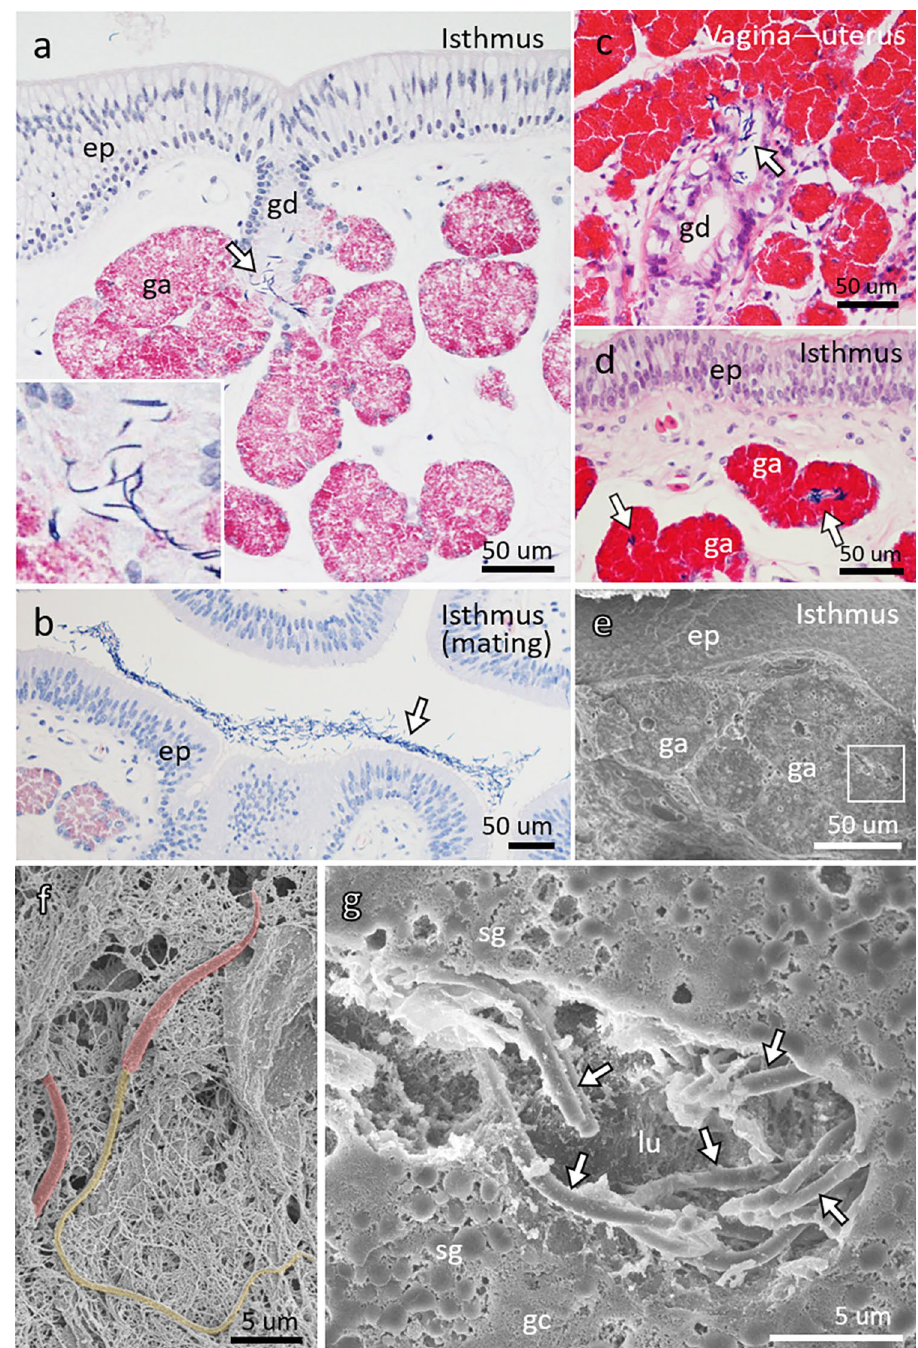
Figure 4. Sperm storage portion in oviduct of green turtle. ( a ) Sperm (arrow) in gland duct (gd) of isthmus in ID-024. Insert is higher magnification of sperm. ep, epithelium; ga, gland acini. ( b ) Sperm (arrow) in lumen of isthmus in ID-028 captured during mating. Spermatozoa are sparse in other parts of oviduct in this individual. ( c ) A few sperm (arrow) in gland ducts (gd) of transition area between uterus and vagina in ID-035. ( d ) Sperm (arrows) in gland acini (ga) of isthmus in ID-035. ( e ) Scanning electron microscopic (SEM) image corresponds to ( d ). Box corresponds to ( g ). ( f ) SEM image of spermatozoon in epididymis of a male green turtle. Red, head; yellow, tail. ( g ) SEM image of spermatozoa (arrows) in acini of isthmus glands. gc glandular cells, lu lumen of acini, sg secretory granules. Bars, 50 ( a–e ) and 5 ( f,g )